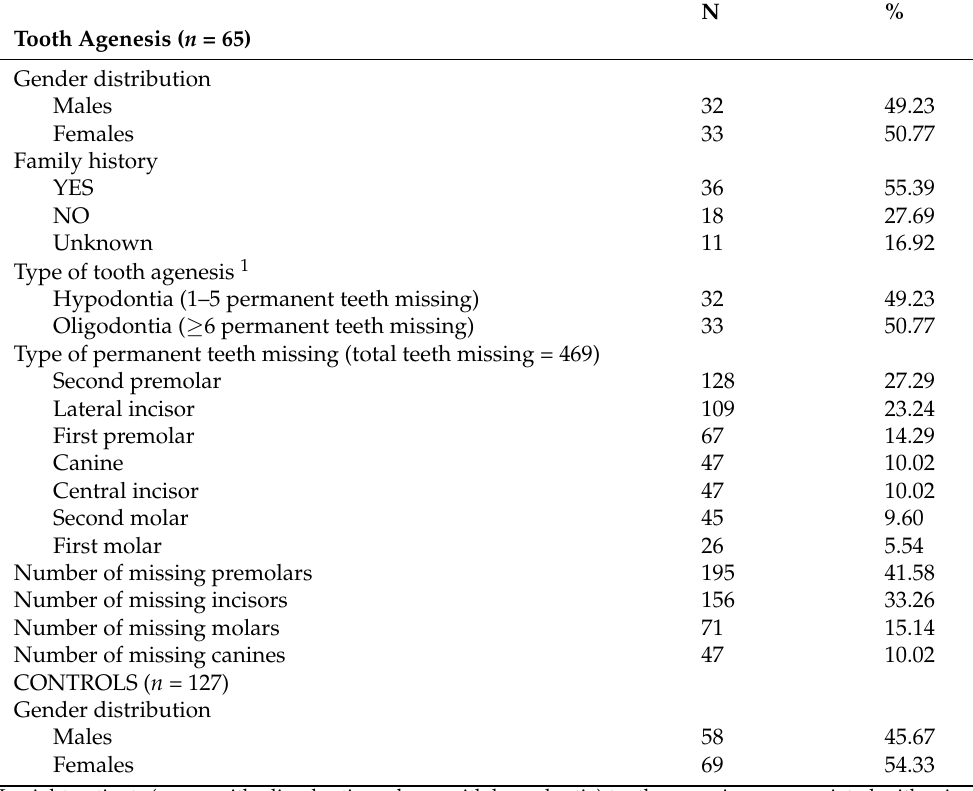
Table 1. Characteristics of the patient and control